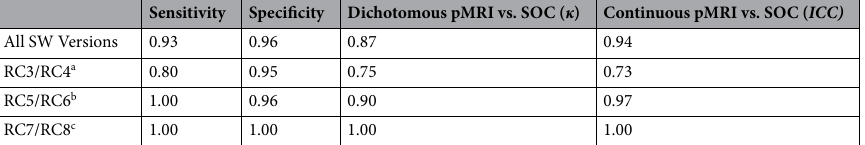
Table 2. Detection and measurement of midline shift using portable MRI. SW, software; κ , kappa statistic; ICC , intraclass correlation coefficient; pMRI, portable MRI; SOC, standard-of-care imaging. a Patients scanned using pMRI software versions RC3 and RC4. b Patients scanned using pMRI software versions RC5 and RC6. c Patients scanned using pMRI software versions RC7 and